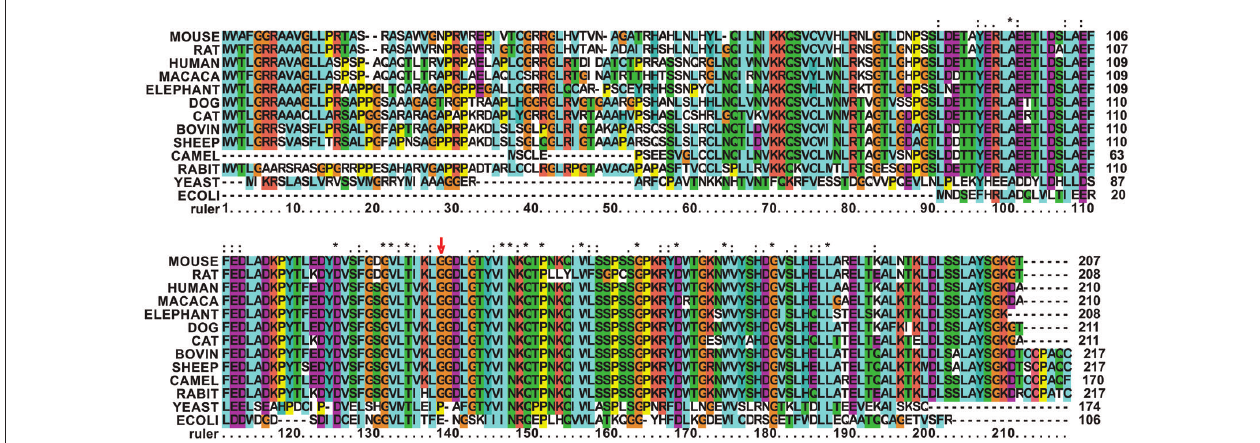
FIGURE 2 | Multiple alignment of mammalian frataxins compared to the yeast and E. coli orthologs . The position of G137 is marked with a red arrow. G137 and in general the loop residues are conserved in mammalians but not in other species. The alignment was done using the freely available Clustalx software (http://www.clustal.org/). Stars stand for completely conserved residues, colons and dots for decreasing conservation.